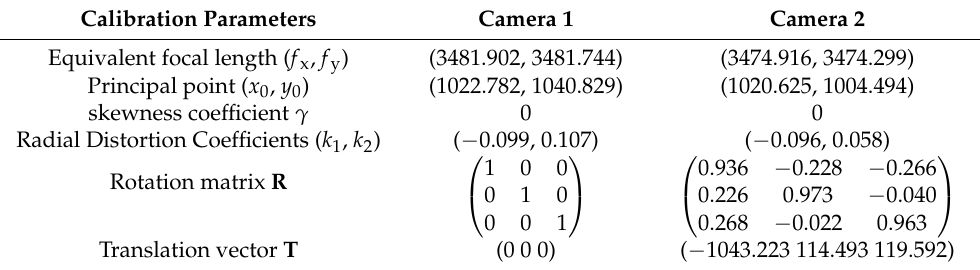
Figure 7. Examples of calibration images taken by (a) camera 1 and (b) camera 2. Table 1. Calibration results. Table 1. Calibration results.